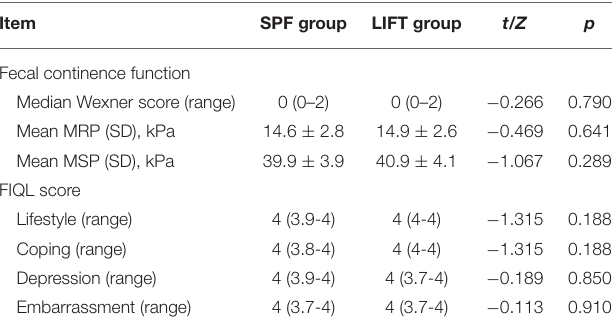
TABLE 3 | Outcomes of postoperative continence function and quality of